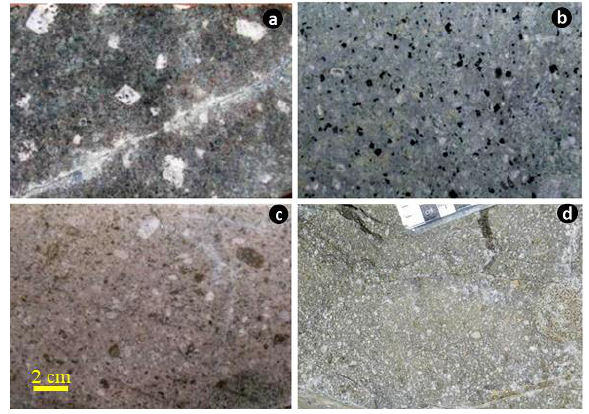
Figure 4. Macroscopic view of different intrusive rocks. ( a ) Intrusive 1: coarse-grained (~1 cm) euhedral K-feldspars within the feldspar-rich groundmass. ( b ) Intrusive 2: medium to fine-grained (1 – 2 mm) subhedral plagioclase, biotite, hornblende phenocrysts within the K-feldspar dominant groundmass associated with biotite and tourmaline. ( c ) Intrusive 2A: intensely altered (kaolinization, sericitization) feldspar phenocrysts within the hydrothermal biotite-bearing clay-rich (phyllosilicate) altered groundmass. ( d ) Intrusive 3: fine-grained (<1 mm) unaltered feldspar and partly-chloritized amphibole phenocrysts within the feldspar and quartz groundmass (note that the width of the photos are 16 cm).